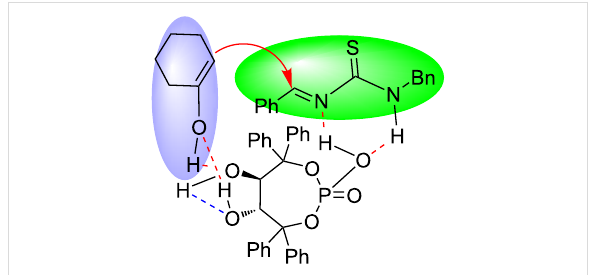
Figure 1: A plausible chiral transition-state structure in the Biginelli-like reaction catalyzed by phosphoric acid 3